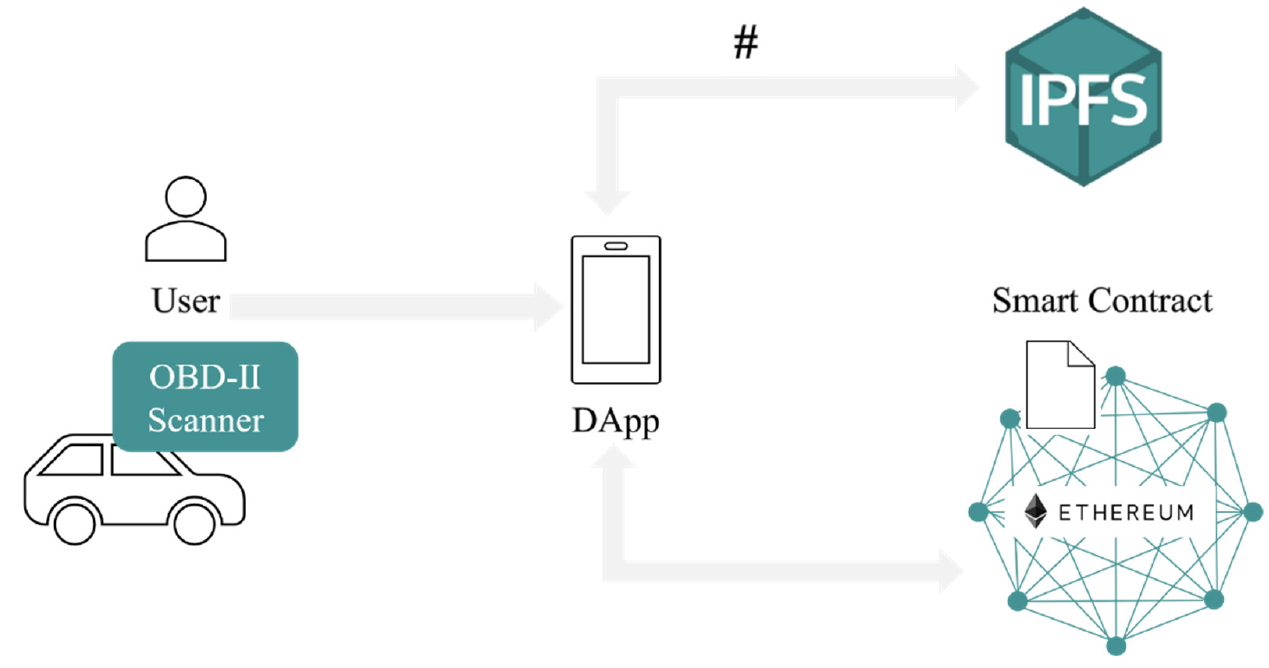
Figure 1. System architecture.